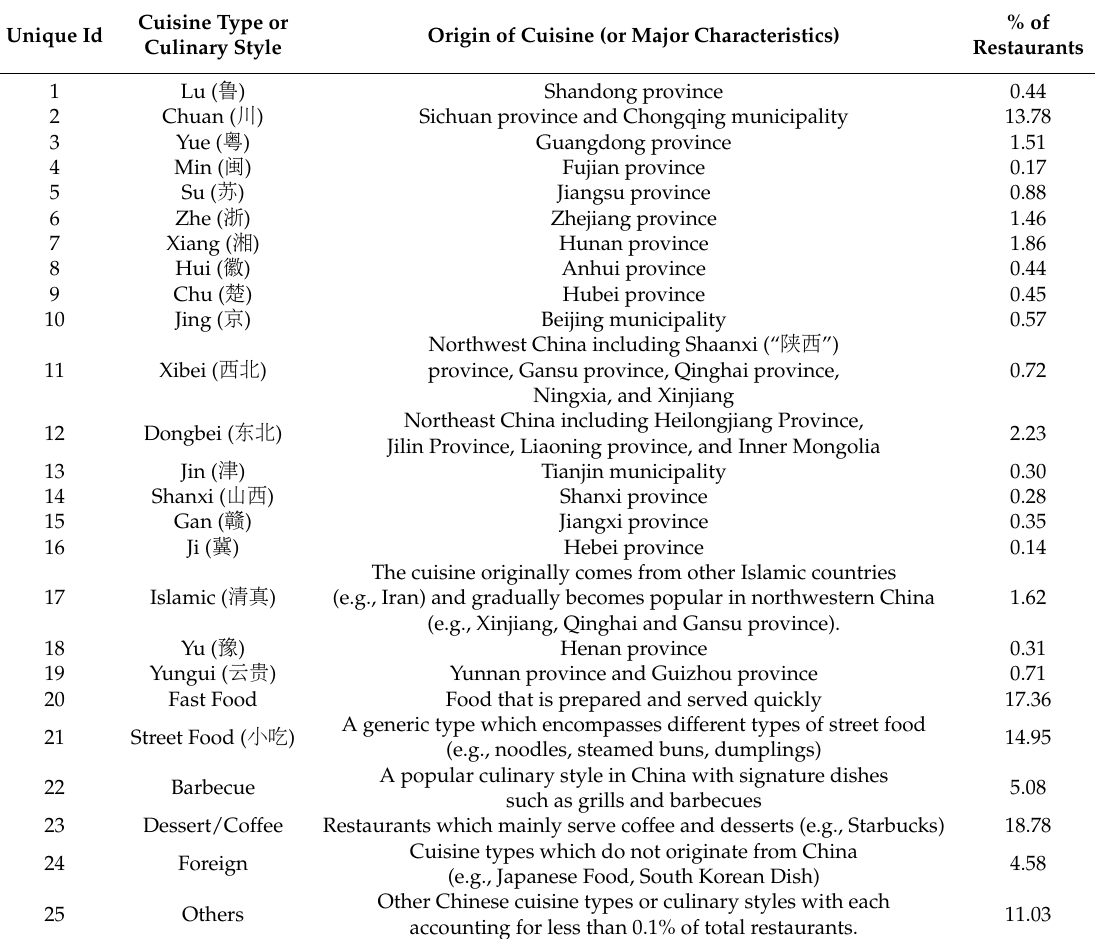
Table 1. Major types of regional cuisines and culinary styles after restaurant